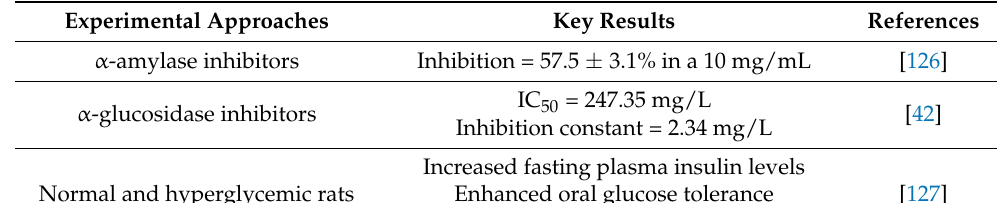
Table 6. Antidiabetic activities of